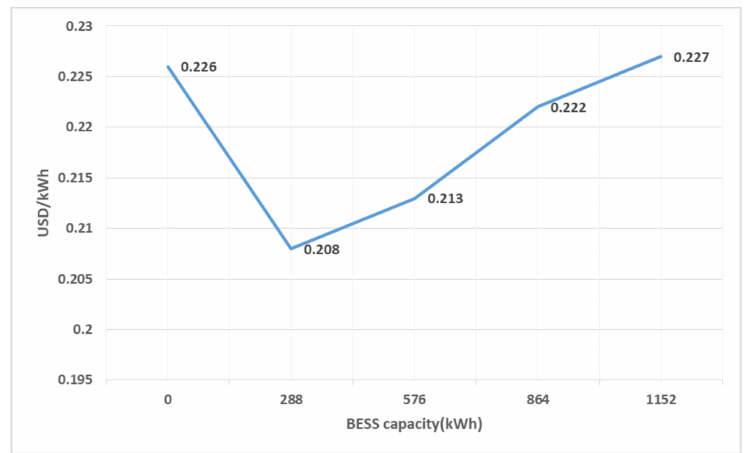
Figure 8. LCOE based on BESS capacity under